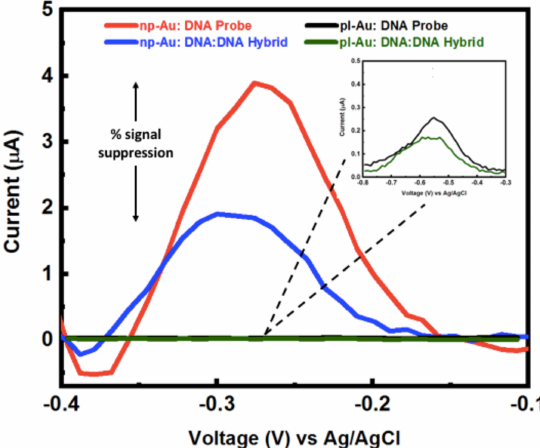
Figure A5. Example SWV raw data for DNA probe and DNA:DNA hybrid current signal in the microfluidic channel for unnanealed np-Au and pl-Au electrodes used to generate Figure 4—Comparison of DNA hybridization efficiency between macro-scale and micro-scale cell sensor configurations for np-Au and pl-Au